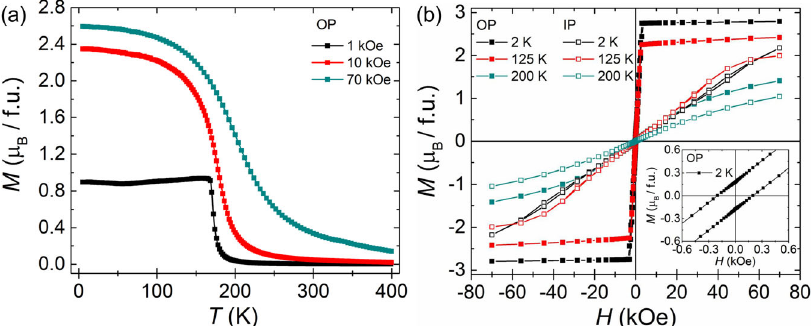
Fig. 2 Magnetic characterization of a Cr 1 + δ Te 2 bulk crystal. a Temperature ( T ) dependence of magnetization ( M ) of Cr 1 + δ Te 2 for several applied magnetic fi elds ( H ) oriented along the out-of-plane direction [0001]. b Isothermal magnetization versus magnetic fi eld oriented along in-plane (IP) and out-of-plane (OP) directions of the single crystalline platelet sample at 2, 125 and 200 K. Inset of b shows the magni fi ed M ( H ) pro fi le at 2 K for the OP